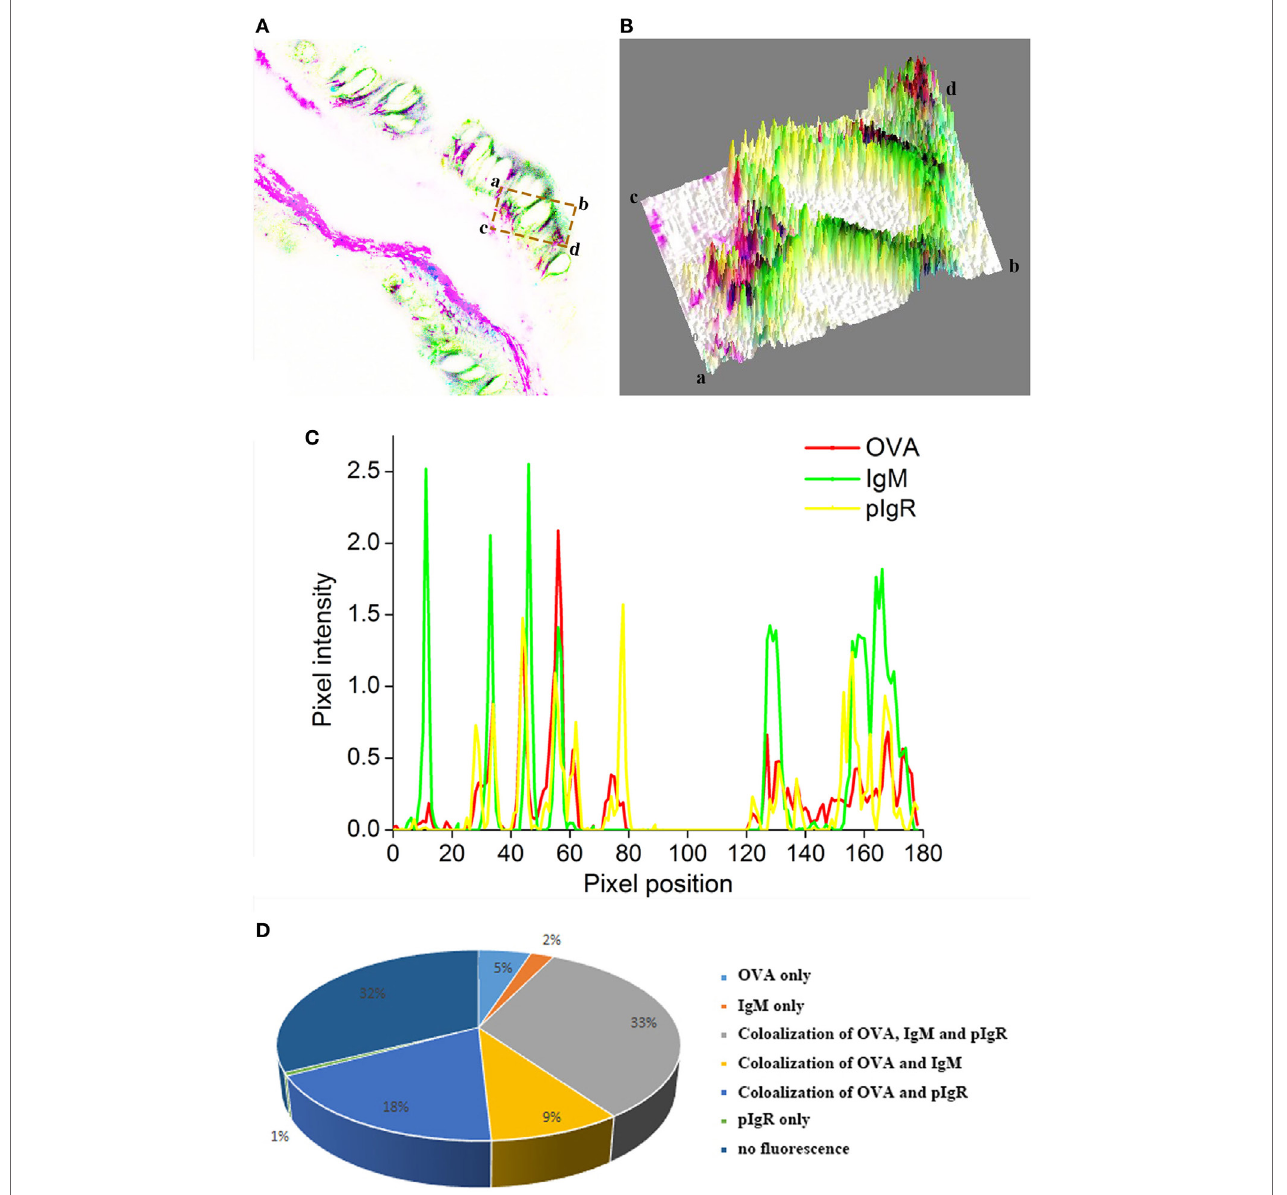
FigUre 6 | Quantitative image analysis for co-localization of ovalbumin (OVA), IgM, and pIgR in a selected area of intestinal epithelium using software Image J. (a) A new merged image of Figures 5a–c using blue, green, and red to represent pIgR, IgM, and OVA-positive signal, respectively. (B) The interactive 3D surface plot of the selected area (rectangle a-b-c-d) of (a) . (c) Analysis of co-localization of OVA, IgM, and pIgR according to the optical density of three fluorescence in the selected area. (D) A pie chart to show the percentage of OVA, IgM, and pIgR